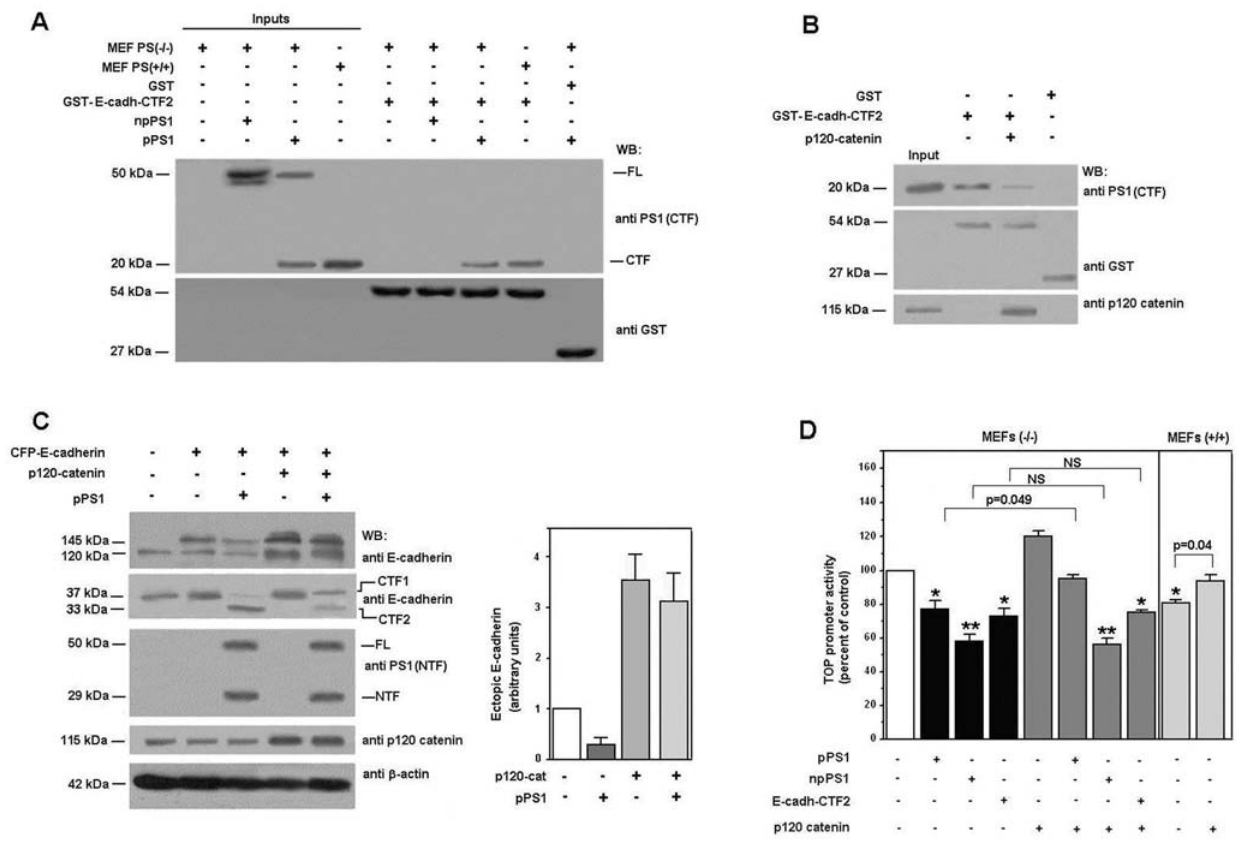
Figure 5. p120-catenin prevents the interaction of pPS1 with E-cadherin, the generation of E-cadherin-CTF2 fragment and the inhibition of b -catenin ? Tcf-4 transcriptional activity. (A) MEF PS ( 2 / 2 ) cells were transfected with npPS1 or pPS1: pcDNA3.1- Myc/His -PS1 (npPS1) or pcDNA3.1-PS1 (pPS1). After 48 h total cell extracts were prepared and incubated with 15 pmols of GST-E-cadh/CTF2 or GST as a control; cell extracts from MEFs PS ( + / + ) were also incubated. Protein complexes were purified with glutathione-Sepharose and associated PS1 was analyzed by Western blotting with a specific antibody against PS1 (C-terminus). Blots were re-analyzed with anti-GST to ensure that similar levels of fusion protein forms were present in all samples. In the Input lane, a sample containing 5% of the total cell extracts used for the assay was loaded. (B) 12 pmol of GST-E-cadh-CTF2 or GST as a control were pre-incubated with 20 pmols of p120-catenin and pulldown assays performed as above with 1 mg of MEF PS ( + / + ) total cell extracts. (C) MEF PS ( 2 / 2 ) cells were cotransfected with 2.5 m g of pECFPN1-E-cadherin and pcDNA3.1-PS1 (pPS1) or pcDNA3.1-p120-catenin. 50 m g of total cell extracts were analyzed by SDS-PAGE and Western blot with the indicated antibodies. At the right, the ectopic E-cadherin levels of three different experiments were quantified and represented with respect to control (no additions). Values are the average + / 2 S.D of these experiments. (D) MEF PS1( 2 / 2 ) cells were cotransfected with pcDNA3.1-PS1 (pPS1), pcDNA3.1- Myc/His -PS1 (npPS1), pcEGFPC1-E-cadh-CTF2, pcDNA3.1-p120-catenin or empty vector (150 ng), TOP-FLASH (50 ng) and pTK- Renilla (10 ng) luciferase plasmids. MEF PS1( + / + ) cells were transfected with pcDNA3.1-p120-catenin or empty vector (150 ng). Relative luciferase activity was determined with a dual luciferase reporter assay system 48 h after transfection, and the result was normalized using the Renilla luciferase activity for each sample. Percentage activity was calculated by comparing levels of luciferase activity with levels after transfection of the empty plasmid alone. Values are the average + / 2 S.D. of three-four experiments performed in triplicate. 2 , absent; + , present. (*) indicates p , 0.05; (**), p , 0.01; in the rest of the comparisons, the p value is shown. NS, not significant.